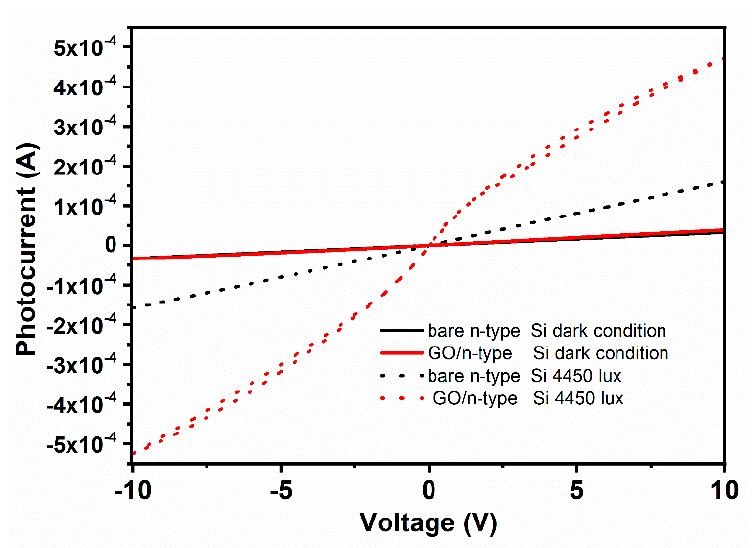
Figure 5. Cyclic voltammetry measurements on n-type silicon and graphene oxide/n-type Si samples under dark and light illumination conditions.